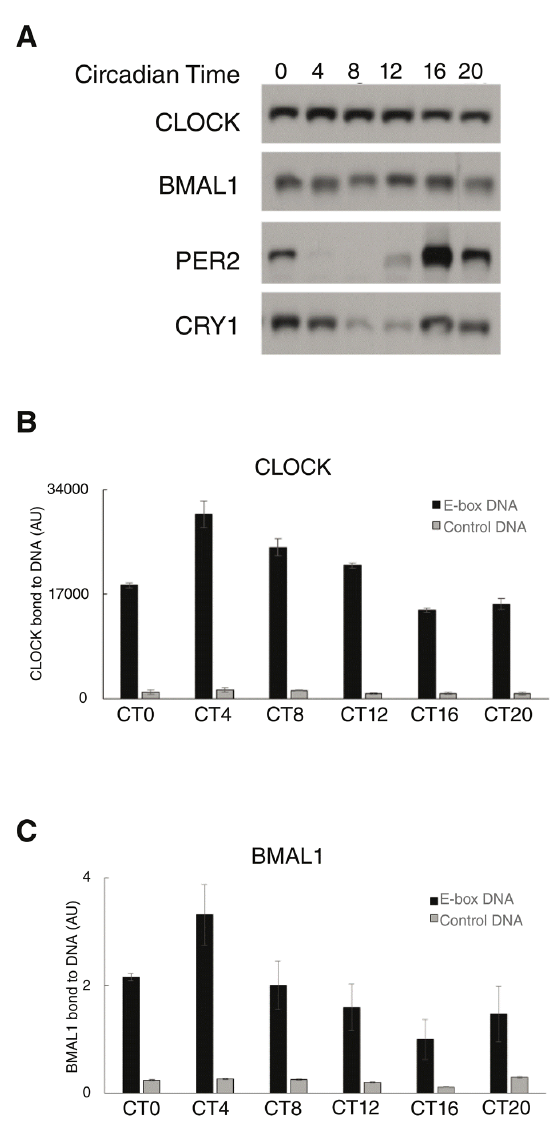
Figure 2. Rhythmic CLOCK-BMAL1 DNA Binding measured by CPDBA. ( A ) Nuclear extracts were prepared from mouse livers harvested over circadian time (CT). Extracts were analyzed by SDS- PAGE/immunoblotting for the presence of CLOCK, BMAL1, PER2 and CRY1. ( B , C ) CPDBA was applied to these extracts to measure DNA binding by CLOCK ( B ) or BMAL1 ( C ) to E-box DNA. Data from technical replicates using extracts from a single mouse are displayed for CLOCK (n=3), and normalized data from multiple mice are displayed for BMAL1 (n=3) The y-axis represents the amount of CLOCK or BMAL1 binding to DNA as measured by the CPDBA